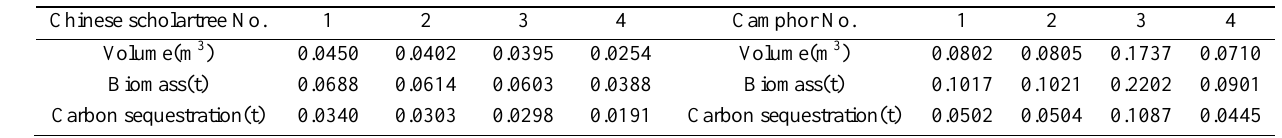
Table 4. Carbon sequestration calculation